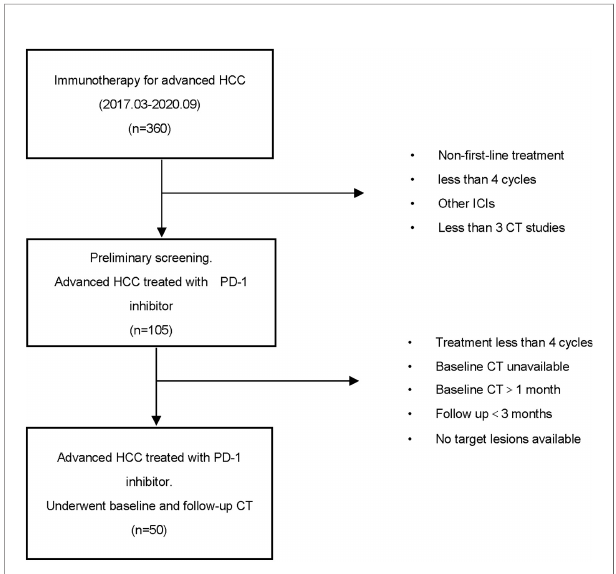
FIGURE 1 | Flow chart shows study population and inclusion